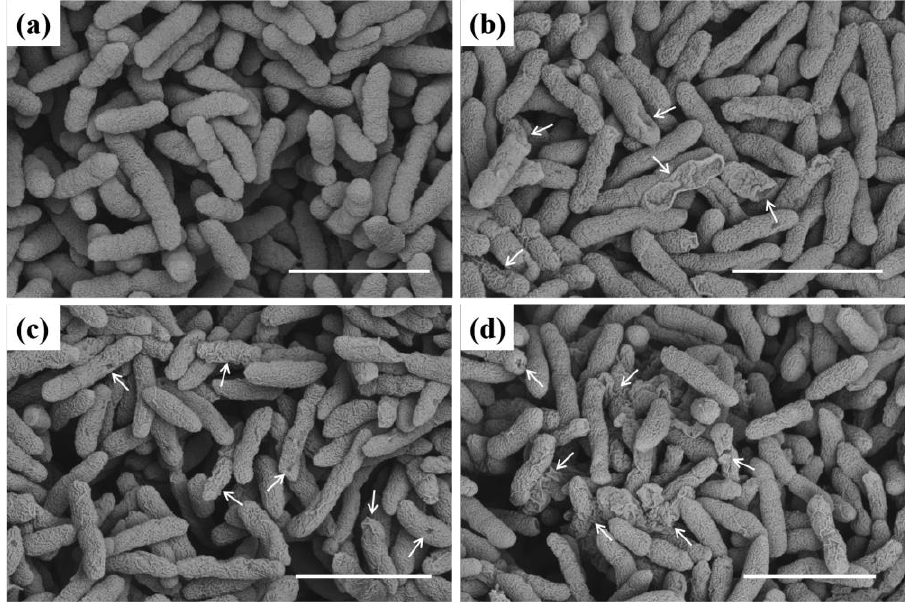
Figure 6. SEM images of Xoo cells incubated with compound C 4 . ( a ) Control, ( b ) 4.04 µg mL − 1 , ( c ) 8.08 µg mL − 1 , and ( d ) 16.16 µg mL − 1 . Scale bars: 2 µm. Arrow represents damaged Xoo .